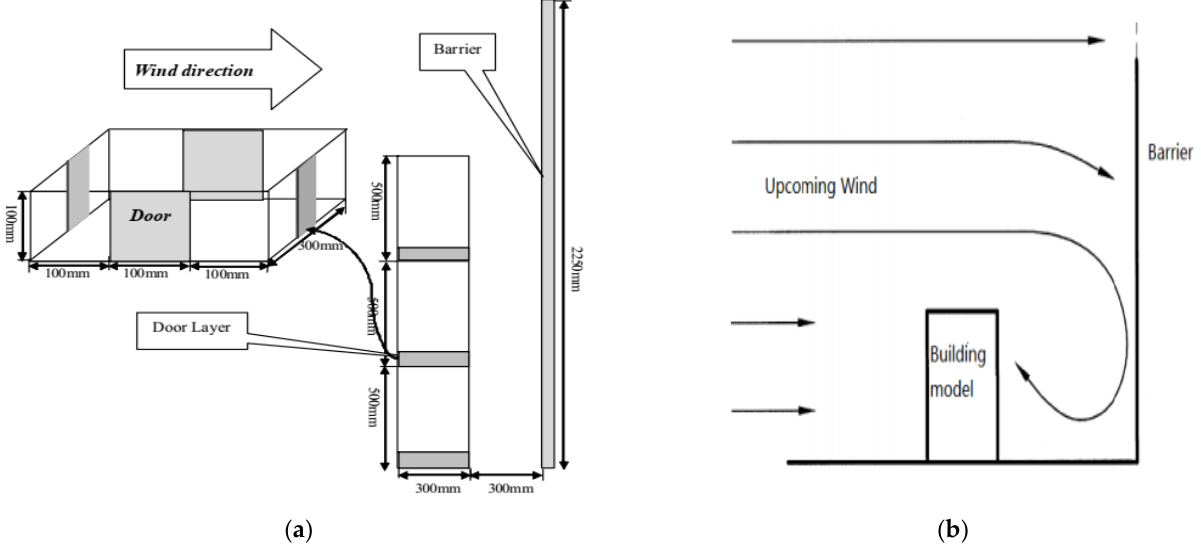
Figure 6. ( a ) Experimental equipment. ( b ) wind flow [60,61].